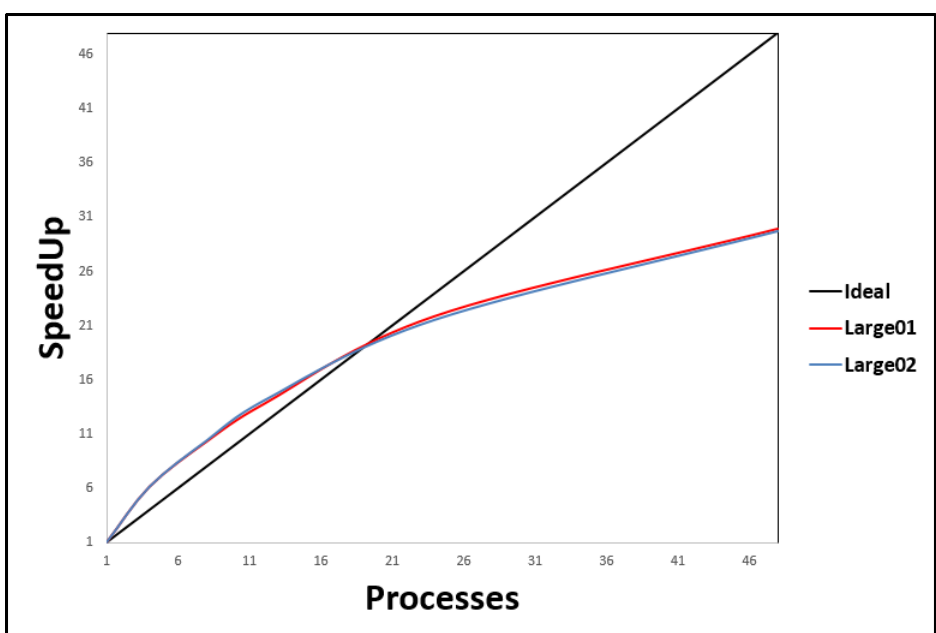
Figure 15. SACP speedup for large UCTP problems.